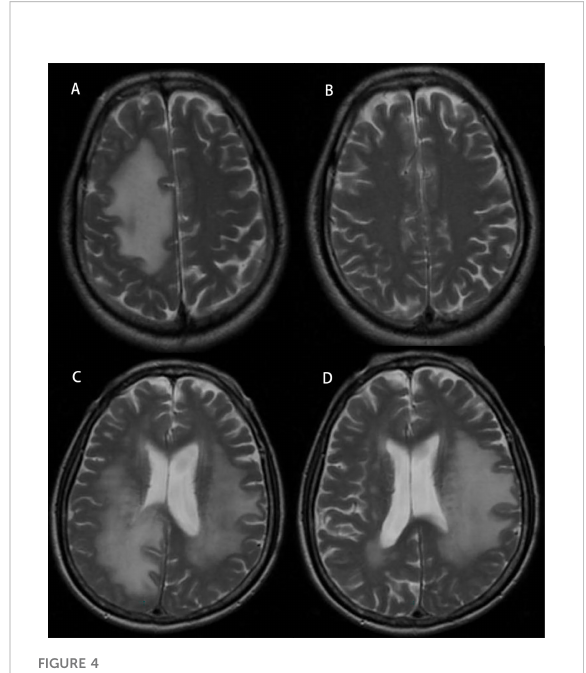
FIGURE 4 Radiographic images of brain edema before and after treatment with bevacizumab. Panel (A) represents edema in a lung cancer patient before treatment, and panel (B) represents after treatment. Panel (C) represents edema in a colon cancer patient before treatment, and panel (D) represents after treatment.